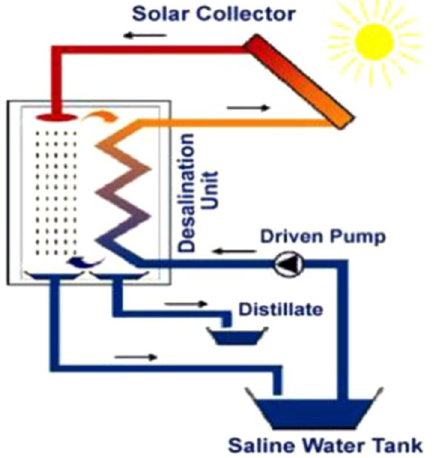
Fig. 27 Schematic of the SHDD process (Valdez Salas and Schorr Wiener